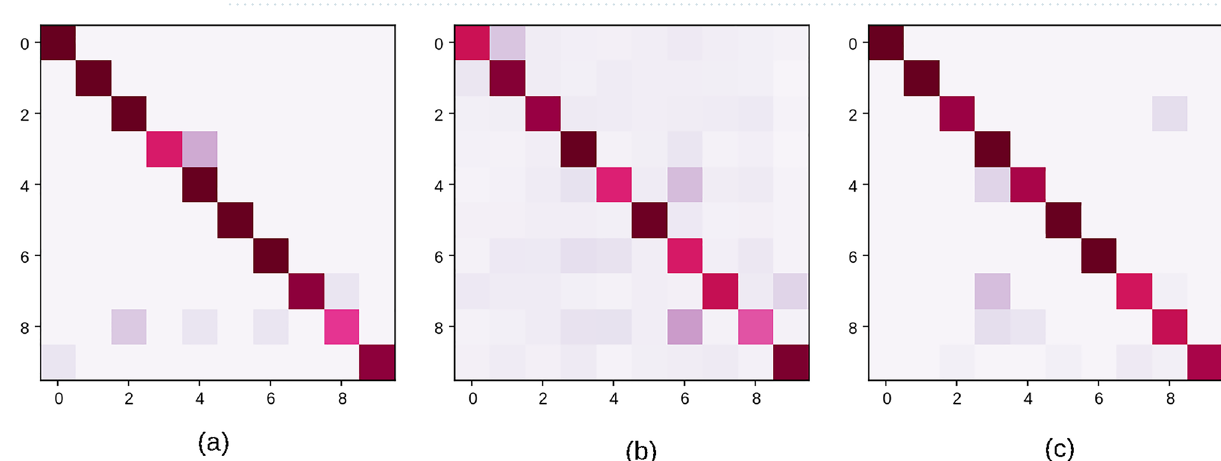
Figure 23. The artifactual linear blank space in the previous figure (Fig. 22) has prominently featured in the first few convolutional layers of VML model (Figure generated by Matplotlib python library, version 3.3.4, https:// matpl otlib. org/).